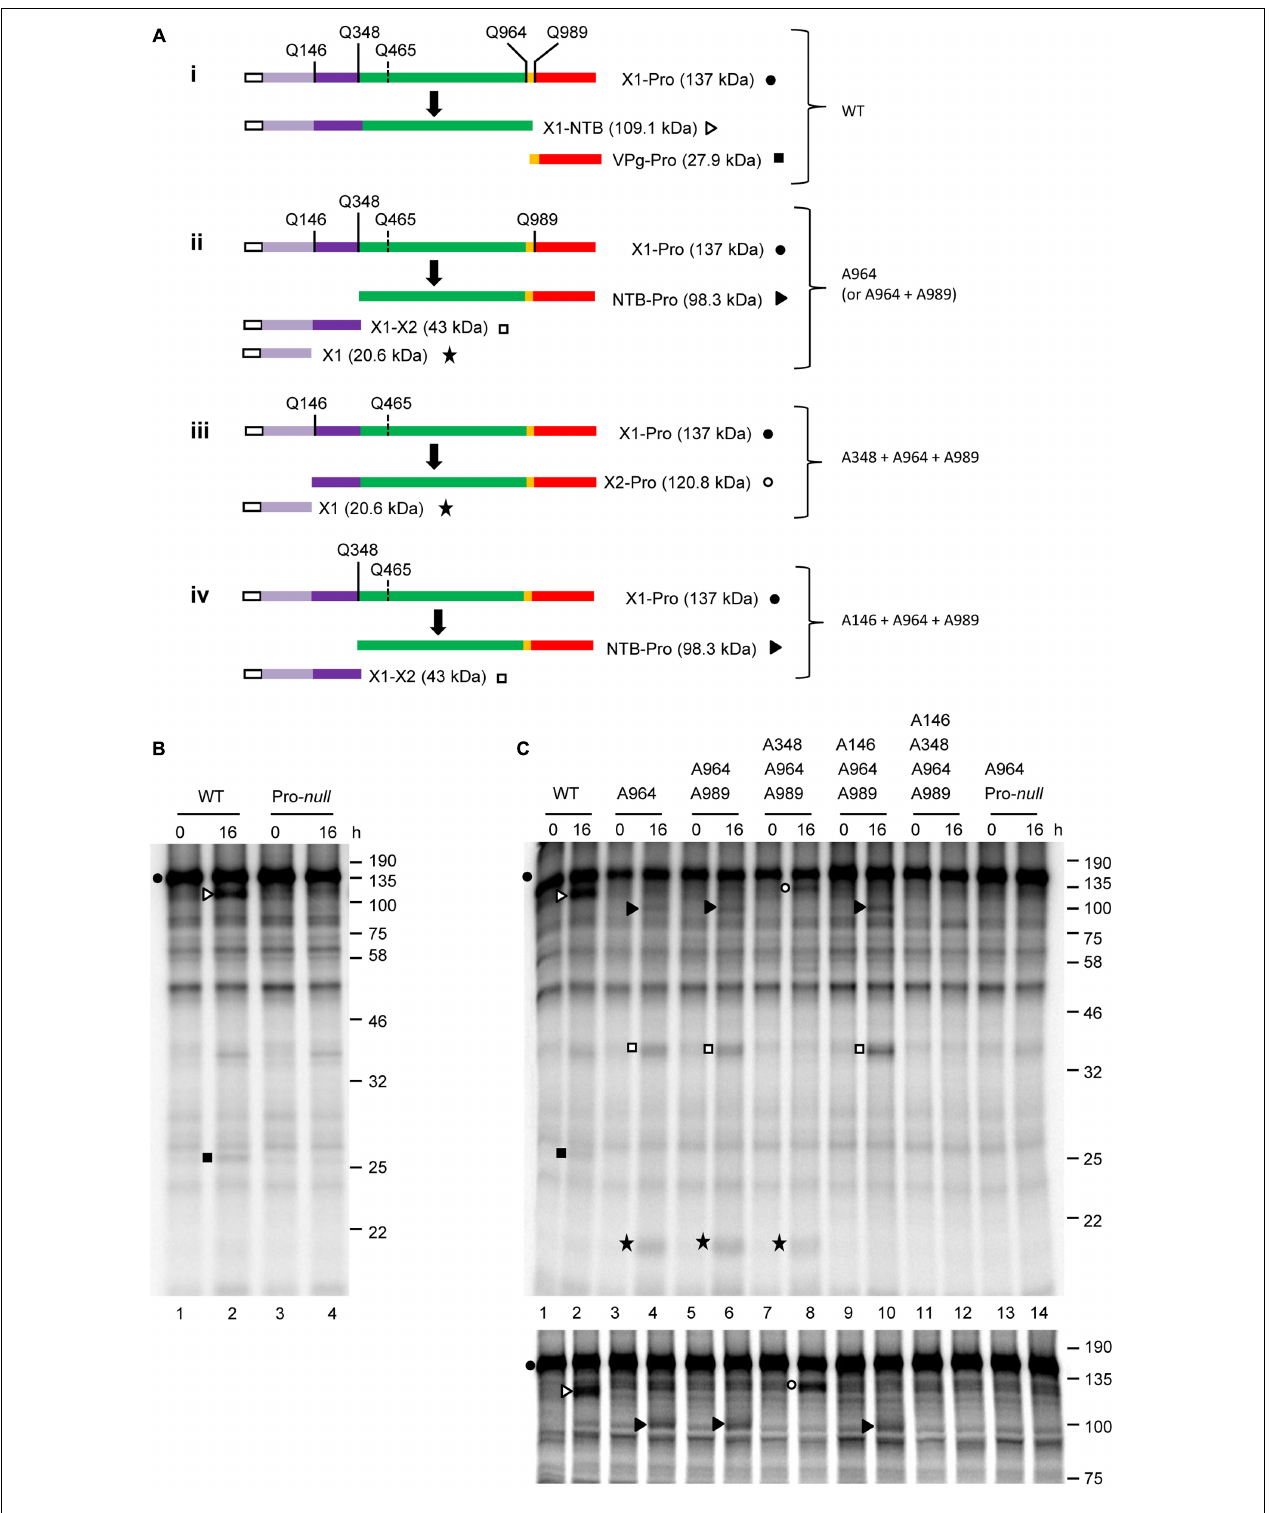
FIGURE 3 | In vitro cis -processing of the X1-Pro polyprotein precursor reveals two additional cleavage sites upstream of the NTB domain. (A) A schematic representation of the X1-Pro precursor polyproteins (wild-type, i and mutant derivatives, ii–iv) and the detected cleavage products is shown. Cleavage sites are depicted as described in Figure 2 . Please note that the predicted Q 465 /G cleavage site is shown with a dashed line since processing was not detected at